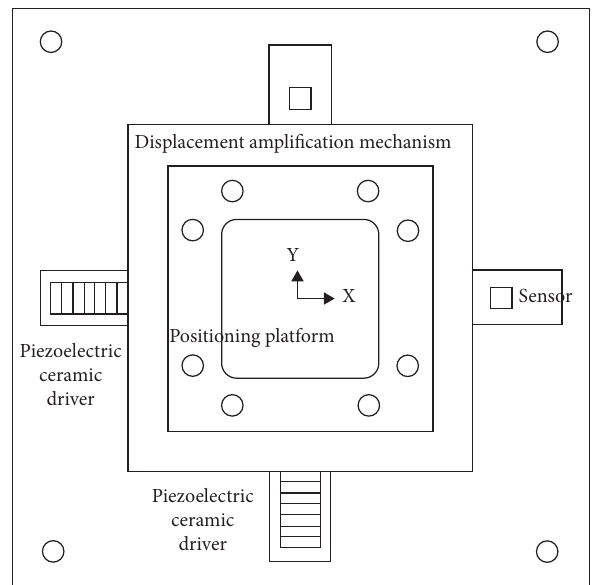
Figure 5: Schematic diagram of the XY piezoactuated compliant platform.